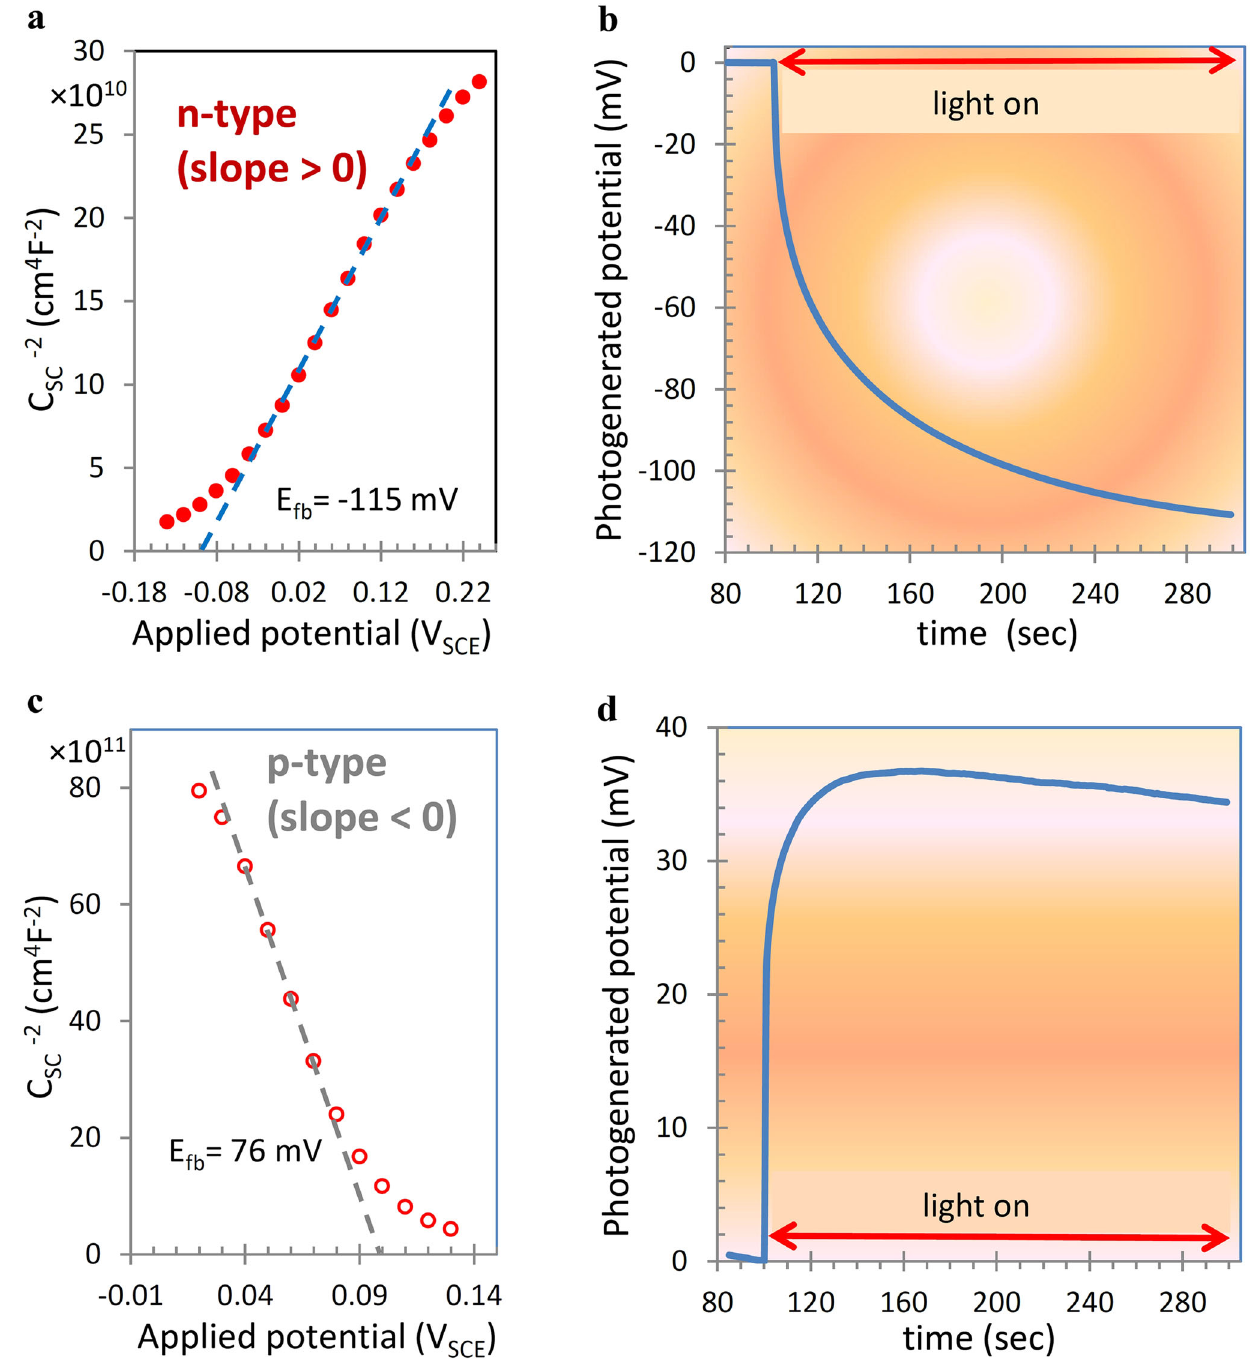
Fig. 3 Mott – Schottky and photovoltage diagrams. a – d are related to hematite and pyrite photoelectrodes, respectively (electrolyte: 0.01 M Na 2 SO 4 ; pH ¼ 7 : 16